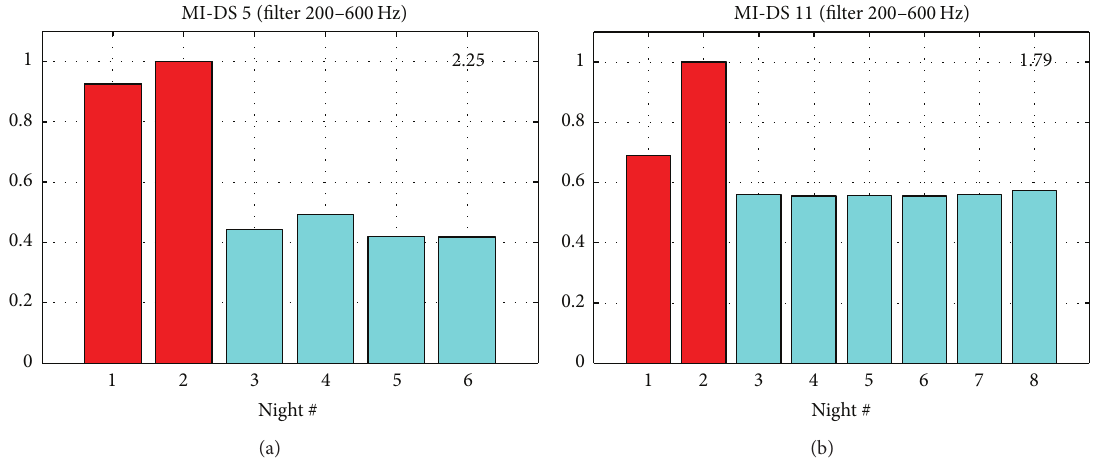
Figure 10: MI computed by the algorithm for filtered signals of datasets (a) DS 5, (b) DS